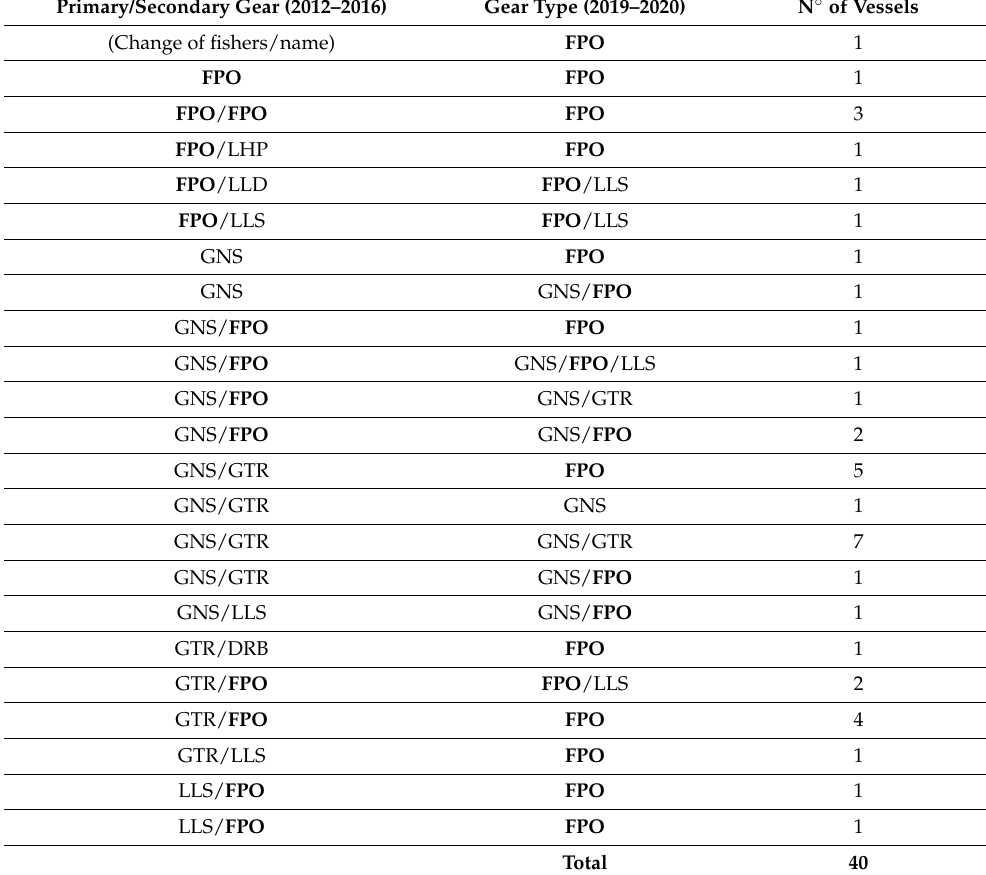
Table A2. Primary and secondary gears in EU Fishing Fleet data (2012–2016) and presently